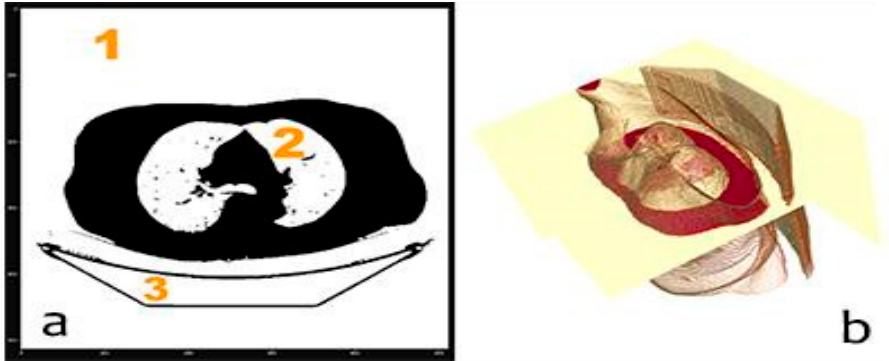
Figure 7. ( a ) 2D non-definitive mask with stretcher and groups of voxels and ( b ) 3D mask volume representation for mask.